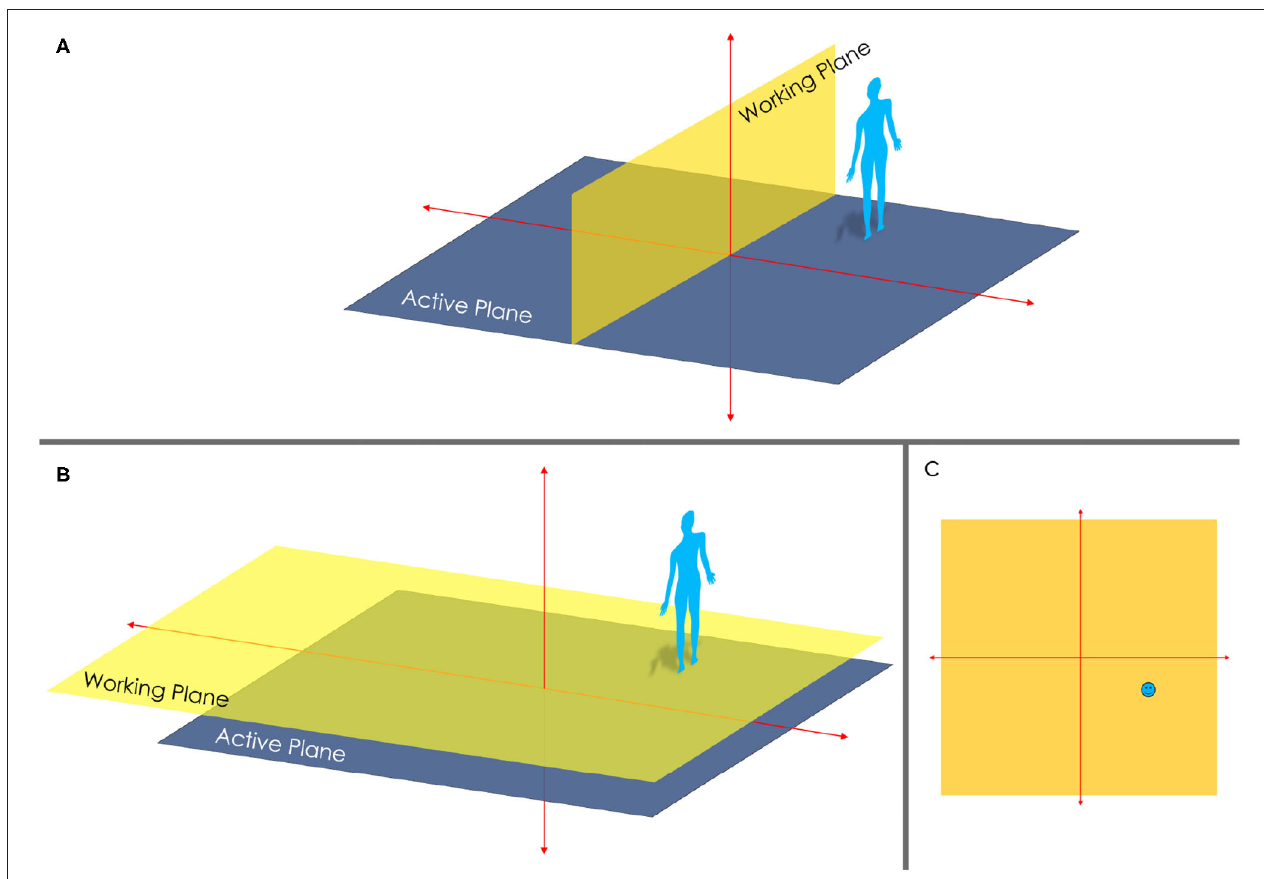
FIGURE 4 | (A) depicts the distinction from a working plane and an active plane in 3D. (B) depicts the transposing of the working plane so that it is parallel to the active plane. This is what happens when transforming a 3D image into 2D. (C) depicts the outcome of transforming a 3D image into